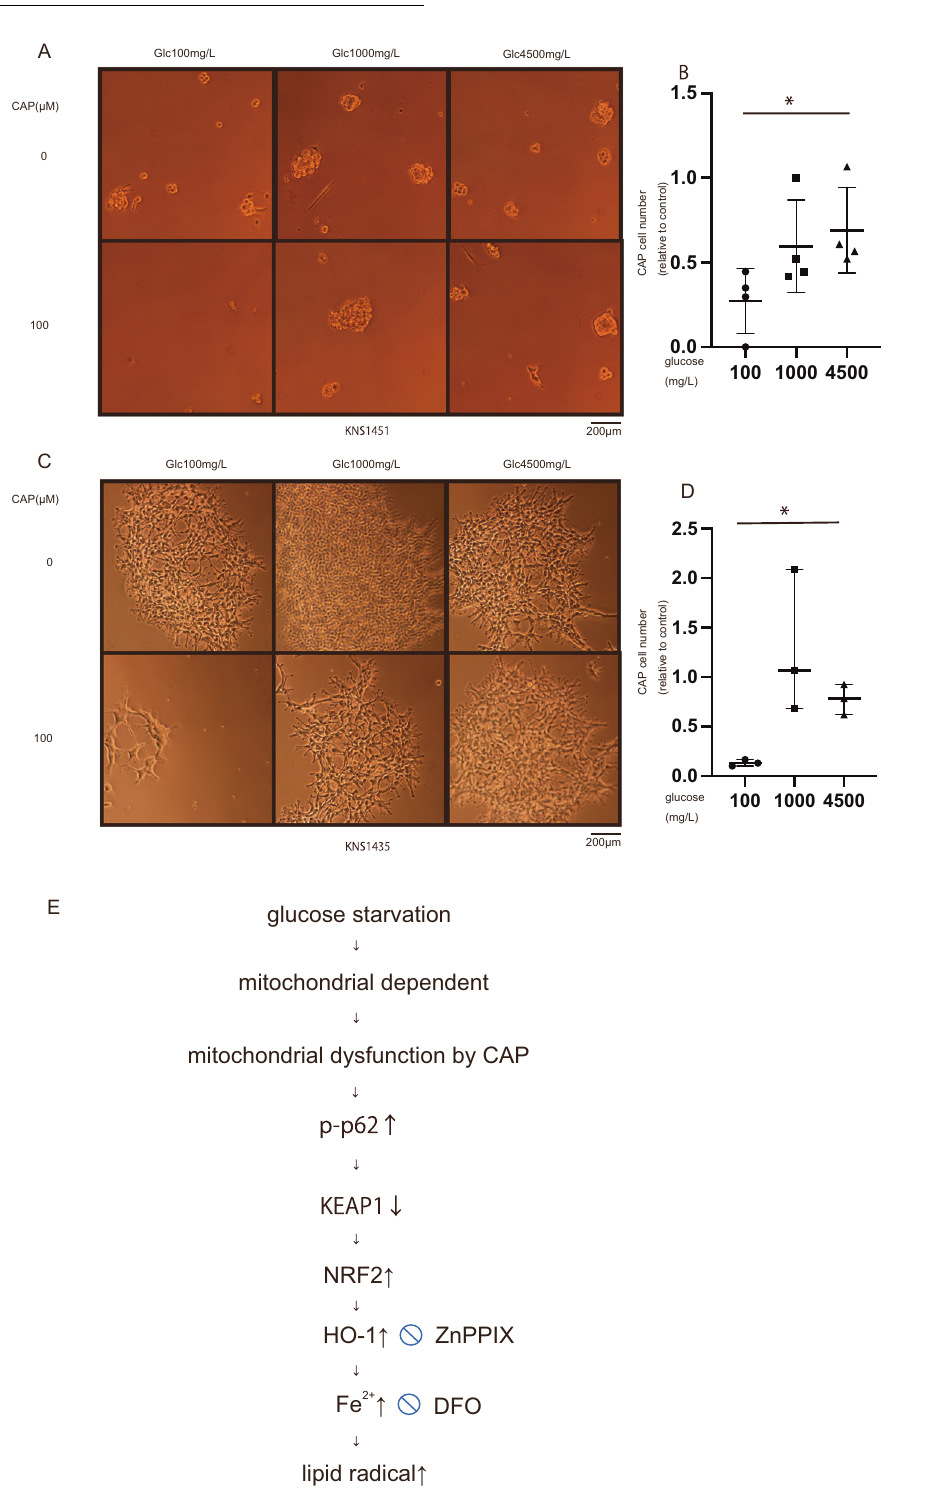
Fig. 6 Effects of CAP in patient-derived stem-like cells. A Relationship between CAP and glucose concentration in KNS1451. CAP was effective at a glucose concentration of 100 mg/l. B Cell viability with CAP under glucose concentrations of 100, 1000, and 4500 mg/l relative to the control showed that CAP was effective under glucose-starved conditions. Values are presented as mean ± SD. Student ’ s t test was performed on glucose 100, 1000, and 4500 mg/l ( N = 4), * p < 0.05. C Relationship between CAP and glucose concentration in KNS1435. CAP was effective under a glucose concentration of 100 mg/l. D Cell viability with CAP under glucose concentrations of 100 mg/l and 4500 mg/l relative to the control showed that CAP was effective under glucose-starved conditions after 9 days. Values are presented as mean ± SD. Ordinary one-way ANOVA test was performed ( N = 3). * p < 0.05. E This scheme shows our proposed novel mechanism for this